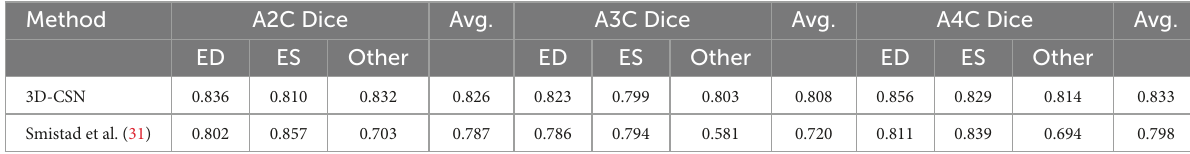
TABLE 1 State-of-the-art method for left-ventricular myocardial segmentation shown at end-diastole (ED), end-systole (ES), and one of other sequence frame compared to